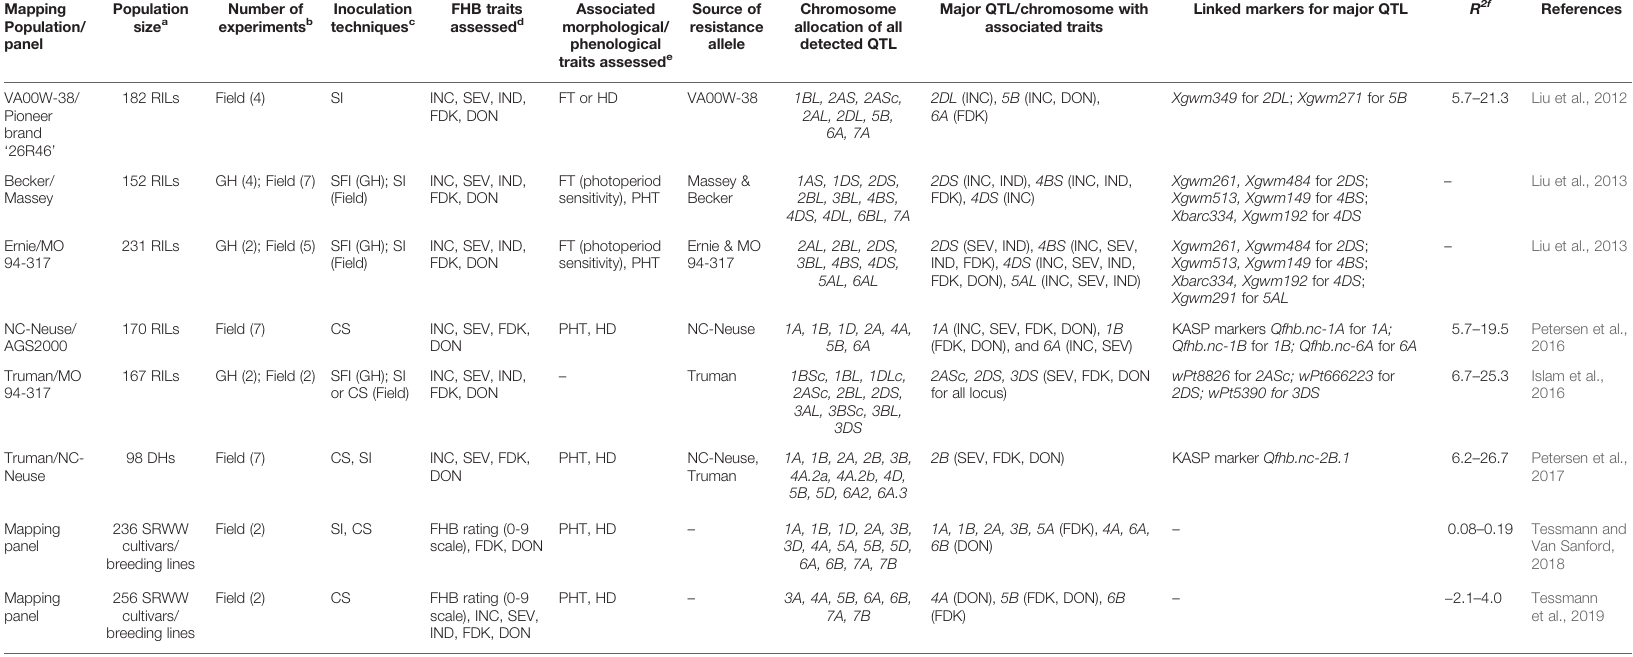
TABLE 1 | Summary of QTL mapping studies for FHB resistance in SRWW in the southeast US. Mapping